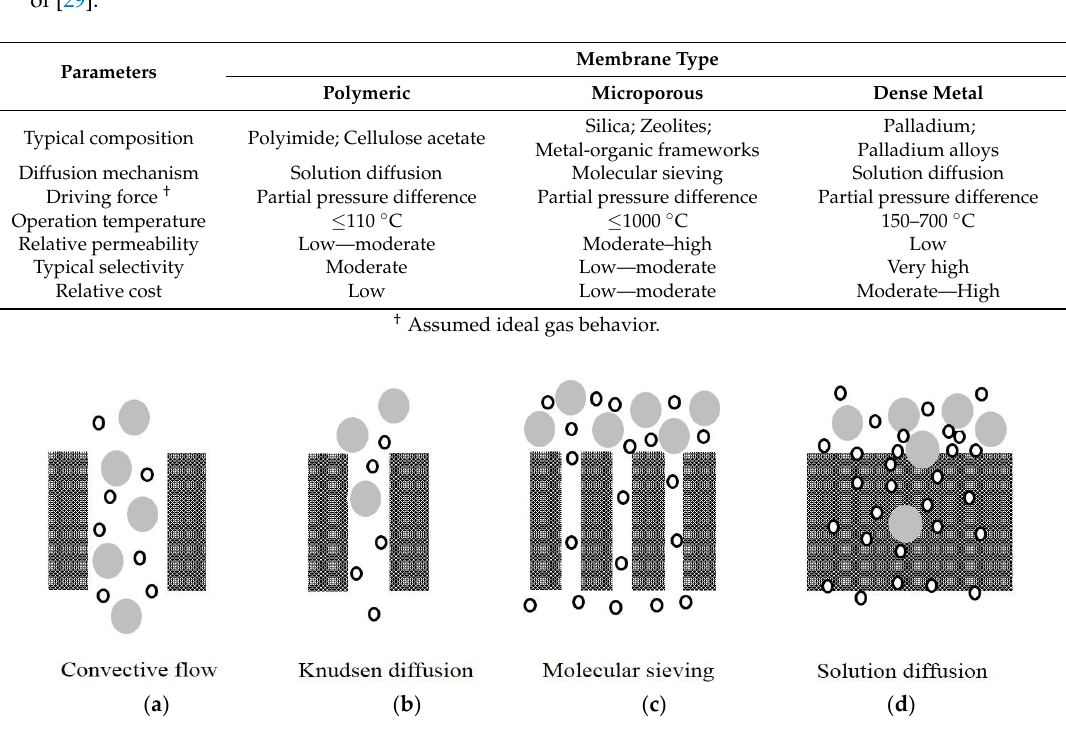
Figure 3. Mechanism for gas separation through ( a – c ) porous and ( d ) dense membranes [30]. Black circle and Grey solid circle represent gas molecules with small and large kinetic diameters, respectively.